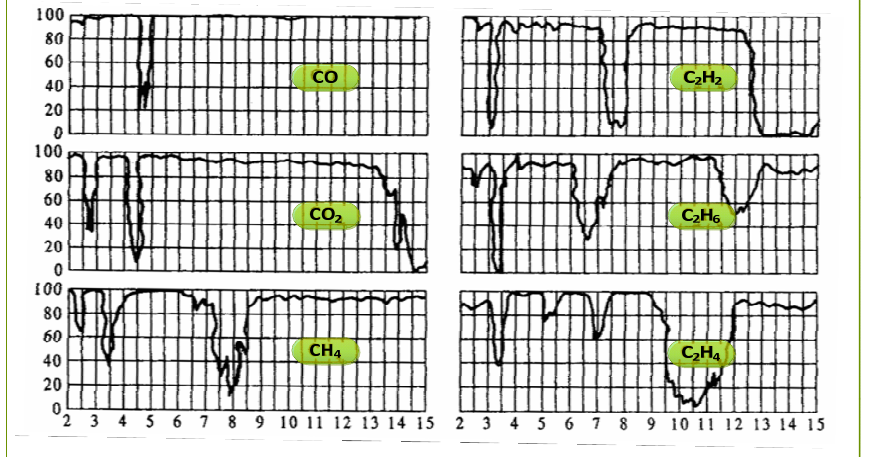
Figure 2. Infrared transmission spectrum of several typical gases.